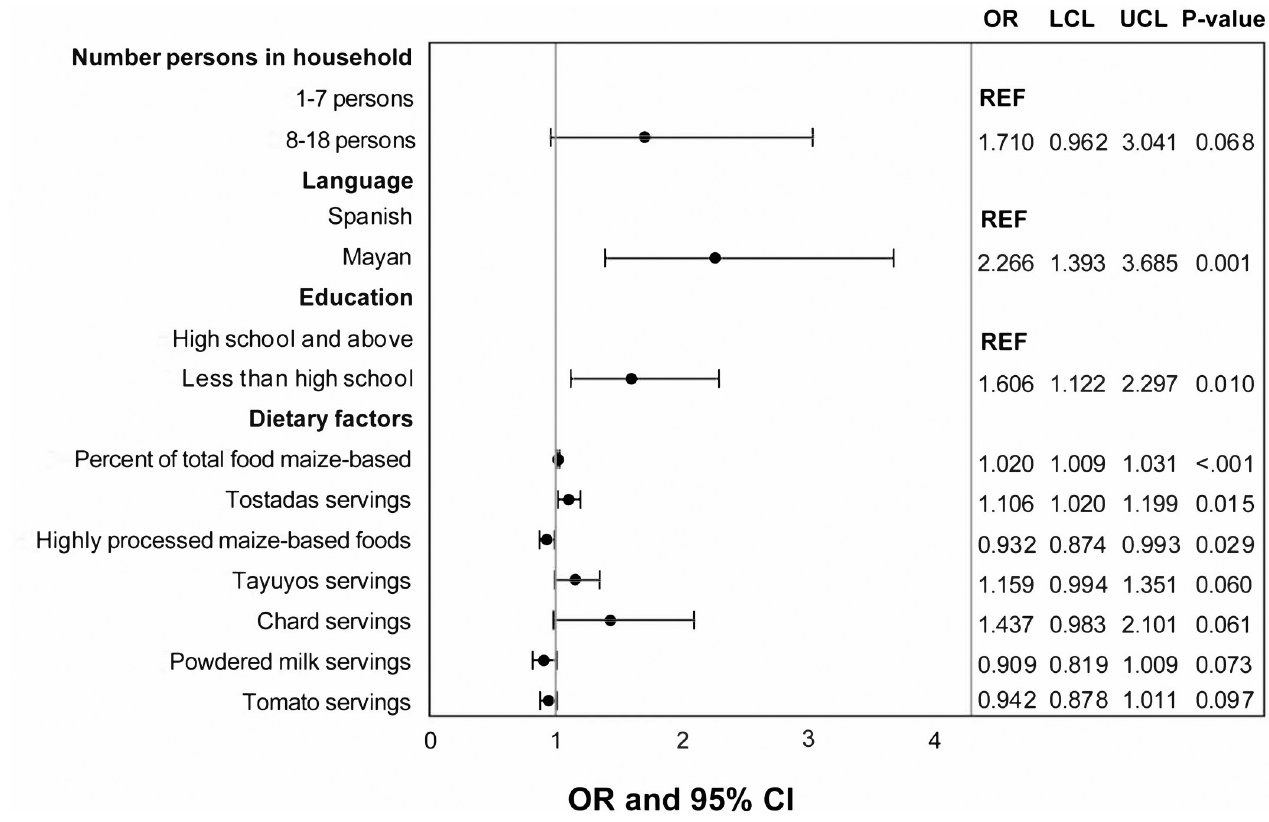
Fig 5. Significant demographic and dietary factors significantly associated with uFB 1 exposure group in multivariable analysis (p < 0.1). Odds ratios (OR), upper (UCL) and lower (LCL) 95% confidence levels, and p-values from logistic regression.